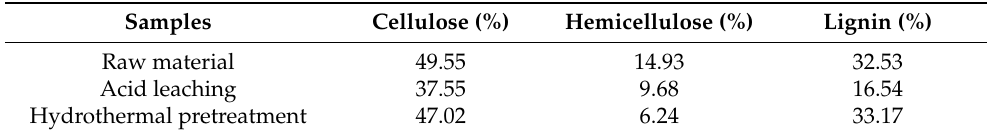
Figure 4. Composition and distribution of pyrolytic bio-oil from different eucalyptus samples ( a – c ), components of pyrolytic bio-oil from raw material, acid leaching eucalyptus and hydrothermal pretreatment eucalyptus. ( d – f ), distribution of pyrolytic bio-oil from raw material, acid leaching eucalyptus and hydrothermal pretreatment eucalyptus. Table 4. Chemical composition of eucalyptus before and after hydrothermal pretreatment and acid